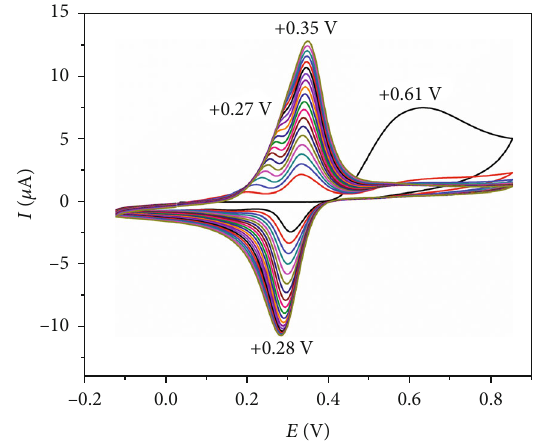
Figure 2: Cyclic voltammetric curves during p(1,5-DAN) fi lm growth onto SPEs for 20 cycles. Solution: 1 mM of 1,5-DAN and 0.1M LiClO in 1 M HClO ; scan rate: 50 mV · s -1 . 4 4